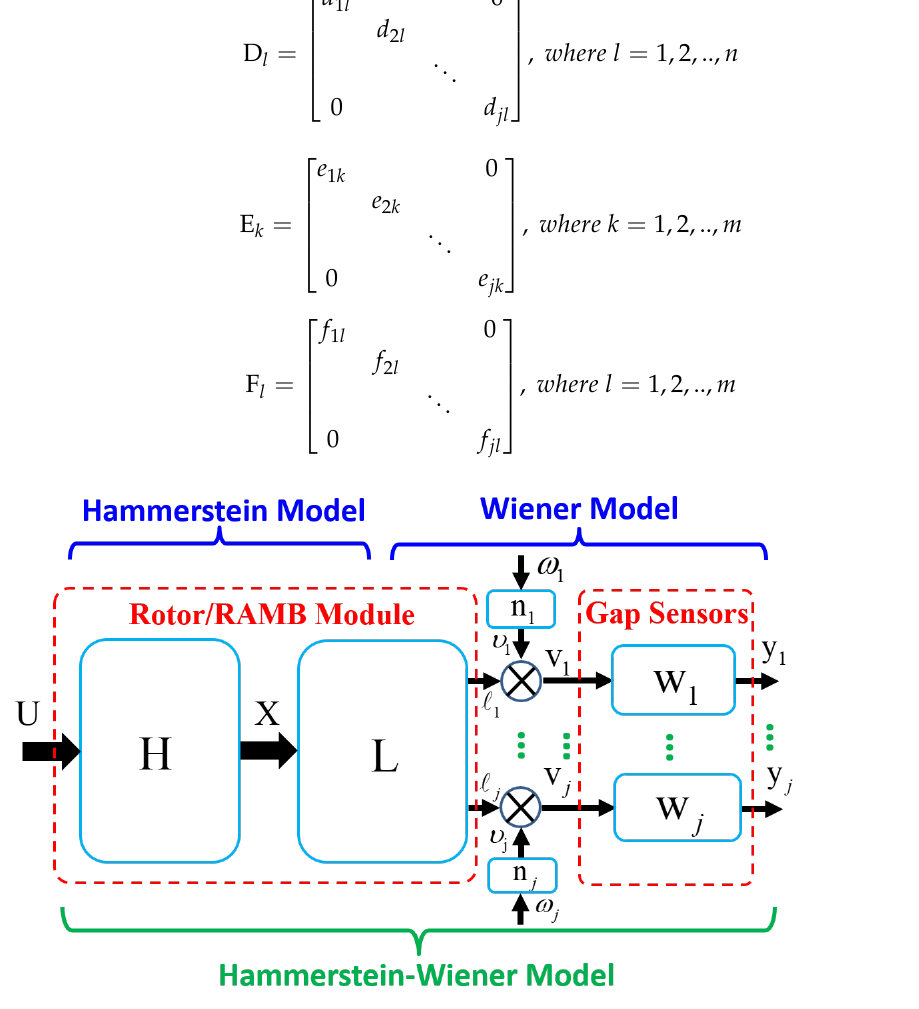
Figure 18. Schematic diagram of MIMO Hammerstein–Wiener model for rotor/RAMB dynamics [32]. The Hammerstein–Wiener model is a gray-box model, which processes the mer- its of the white-box model and the black-box model. To reduce the uncertainties of the Hammerstein–Wiener model but keep the nonlinearities of the dynamic model, we can mea- sure the characteristics of the gap sensors prior to the process of parameter estimation. The parameters of the inverse equations of static nonlinear elements shown in Equation (25) are known. The remaining parameters to be estimated are the part of the Hammerstein model, i.e., Equations (23) and (24). Equations (23) and (24) are organized into one multivariable regression equation